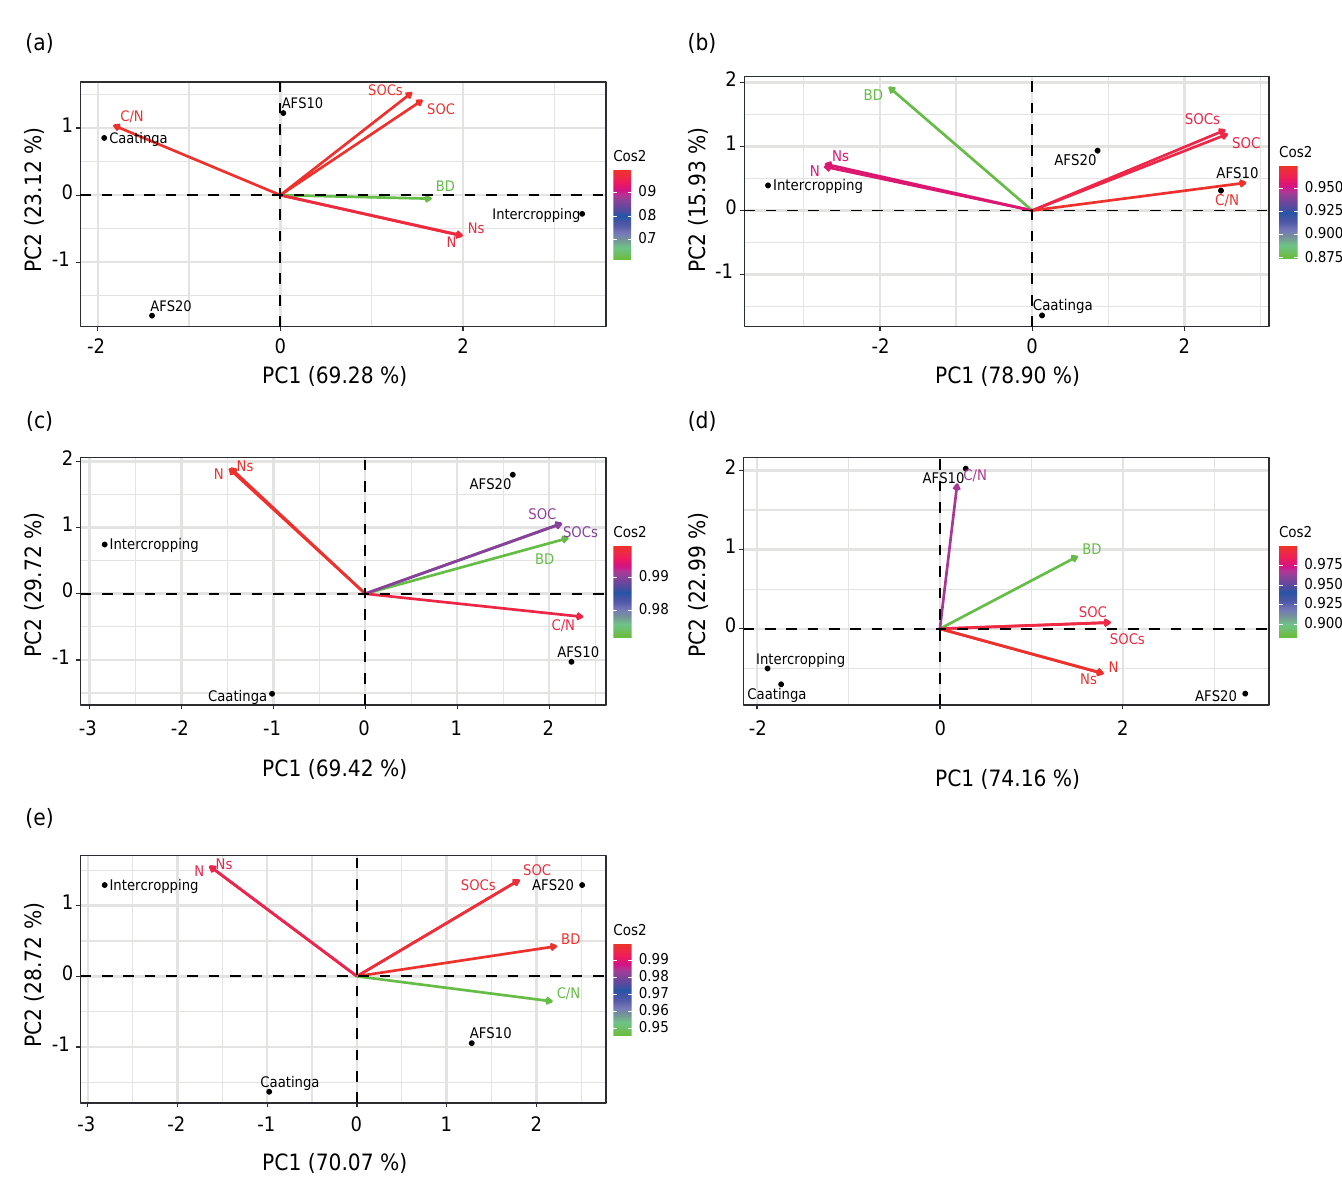
Figure 2. Biplots of principal component analysis between the carbon (SOC), nitrogen (N) content and SOC and N stocks (SOCs and Ns), C/N ratio and soil bulk density (BD) under the managements Intercropping, Caatinga and agroforestry systems (AFS10, AFS20) for the first two main components (CP1 and CP2), for the soil layers 0.00-0.10 (a), 0.10-0.20 (b), 0.20-0.40 (c), 0.40-0.60 (d) and 0.60-1.00 m (e). AFS10: Agroforestry with strips of native forest 10 m wide; AFS20: Agroforestry with strips of native forest 20 m